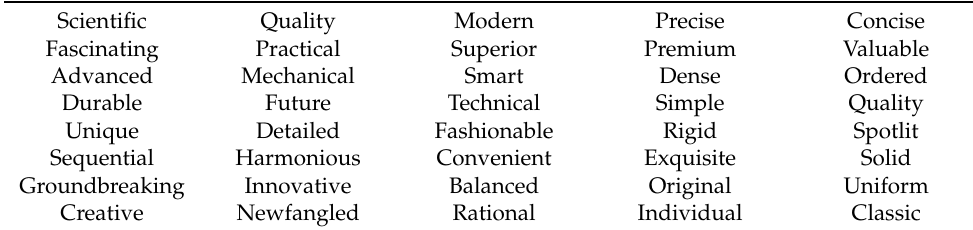
Table 5. The 40 adjectives that were most recognized.